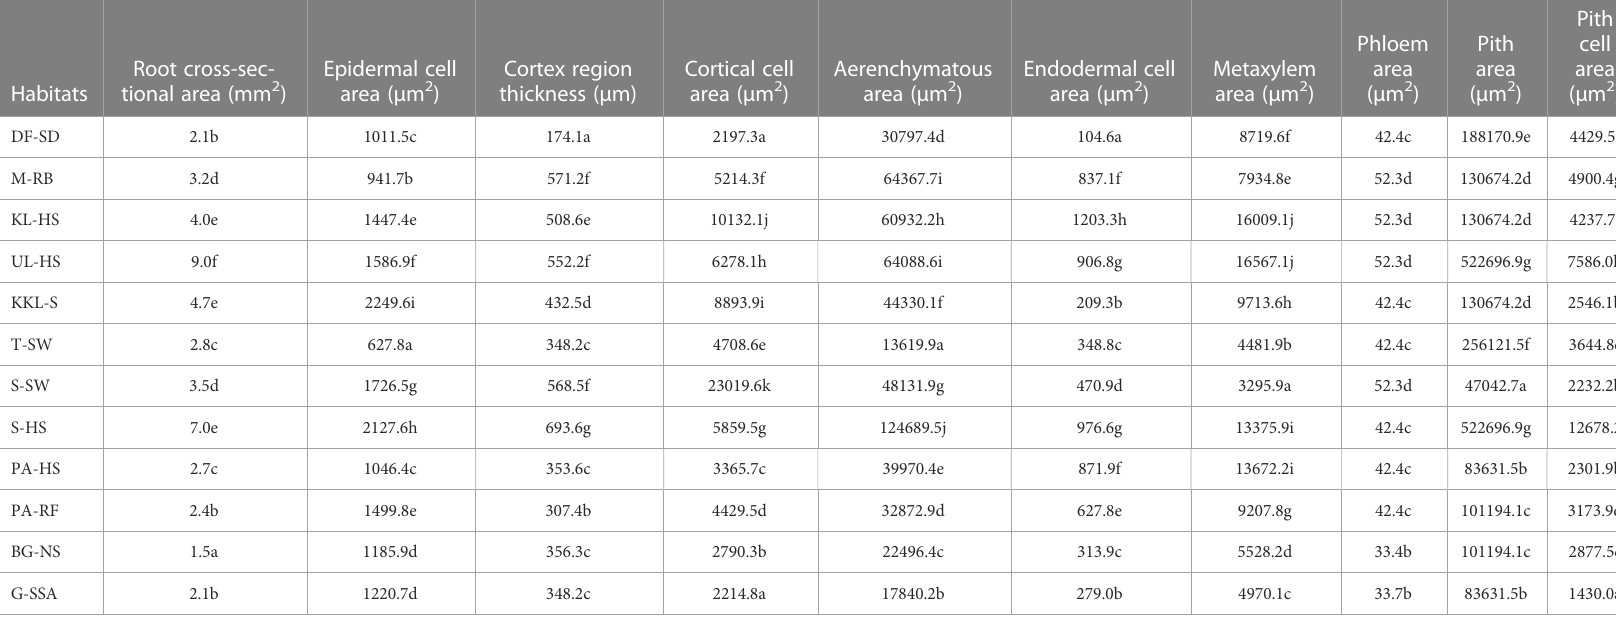
TABLE 2 Root Anatomical characteristics of the selected habitats from Punjab, Pakistan.